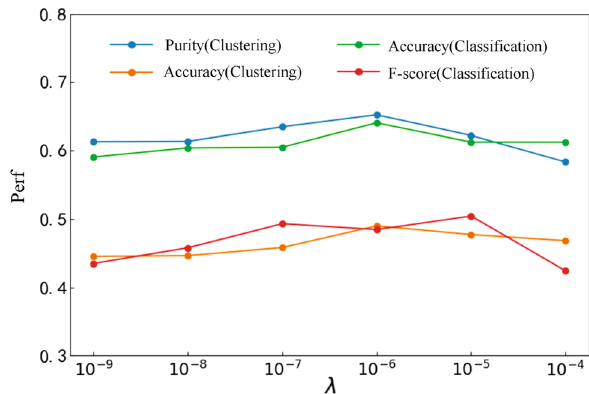
Fig. 3 Effect of hyper-parameter 𝜆 on model